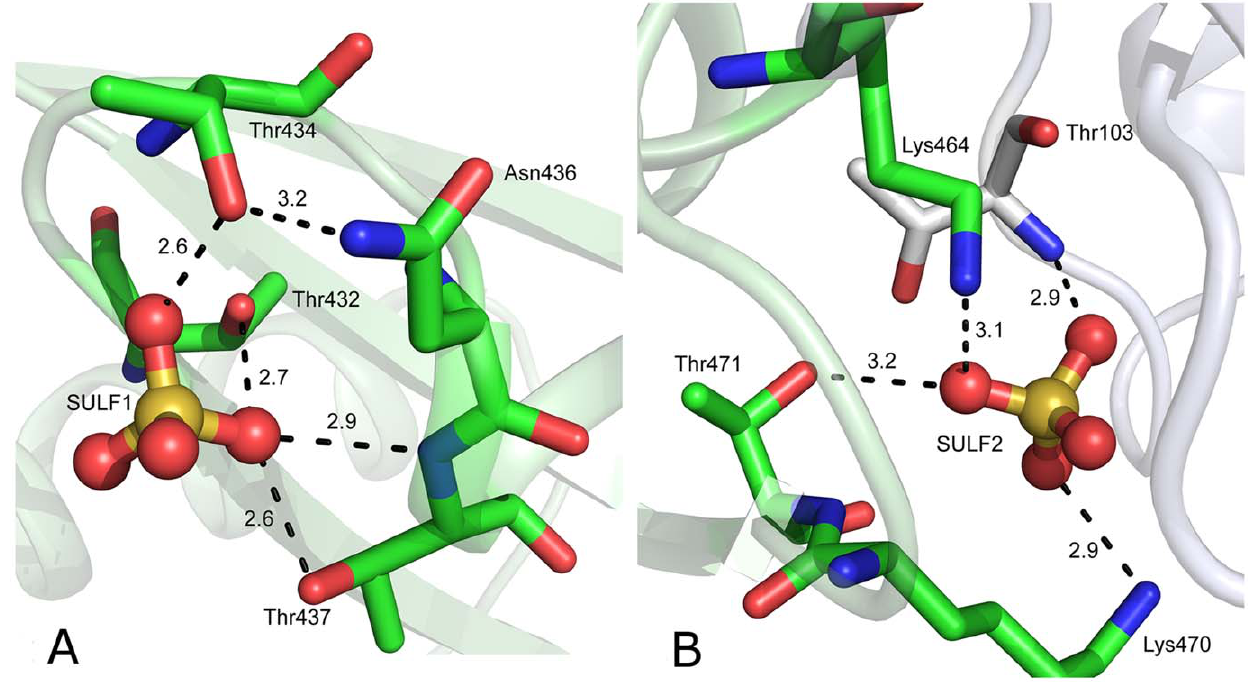
Figure 6. Binding of sulfate ions in CpPyK. Potential hydrogen bond donors and acceptors are indicated by dotted lines with distances in A˚. (A) SULF1 and nearby residues in the allosteric site. (B) SULF2 and nearby